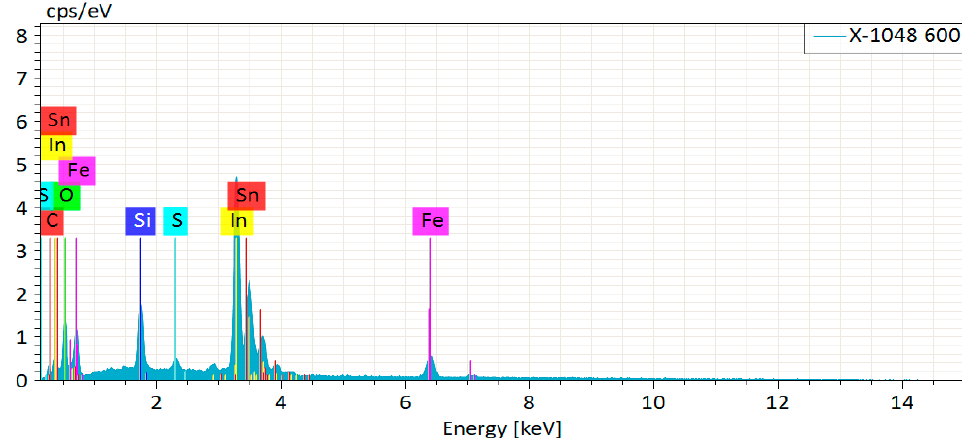
Table 1. Atomic percentage of the precursor fi lm deposited at − 1.0 V.